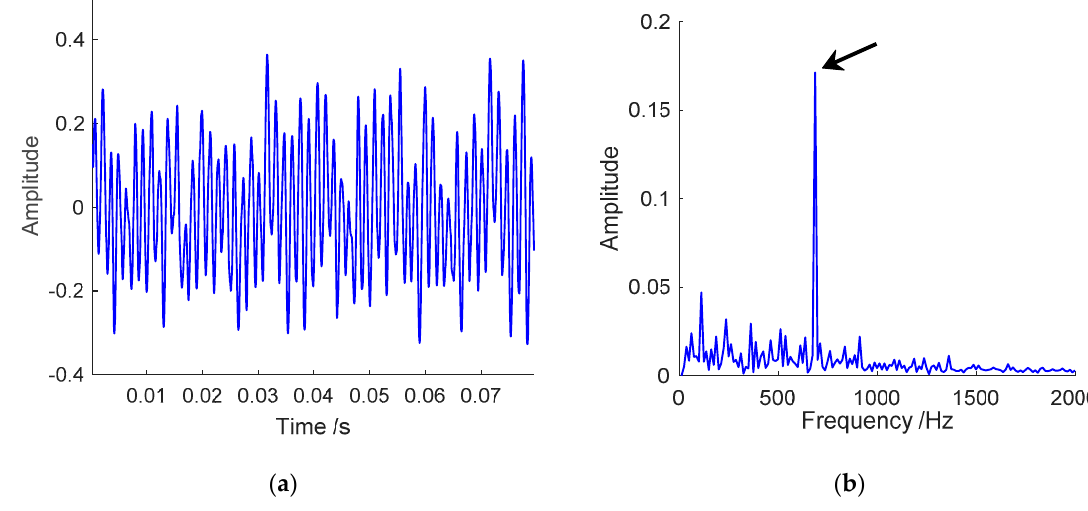
Figure 24. The results of envelope analysis based on reconstructed TFD 2: ( a ) Envelope waveform; ( b ) envelope spectrum.